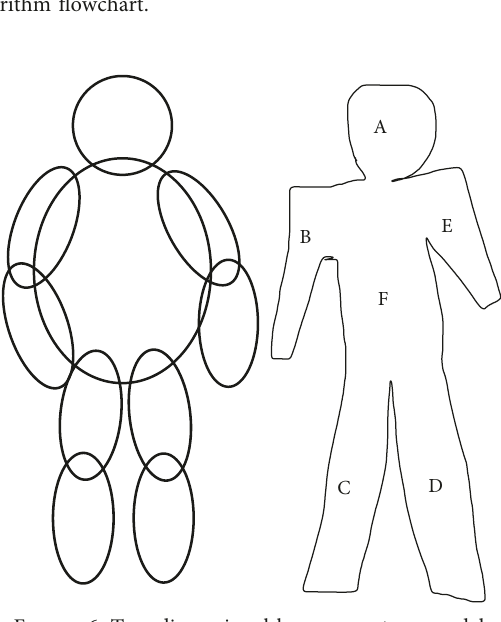
Figure 6: Two-dimensional human contour